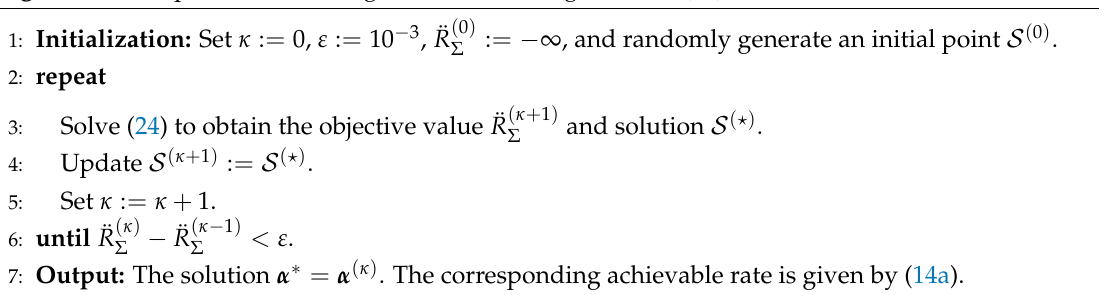
Algorithm 1 Proposed iterative algorithm for solving Problem